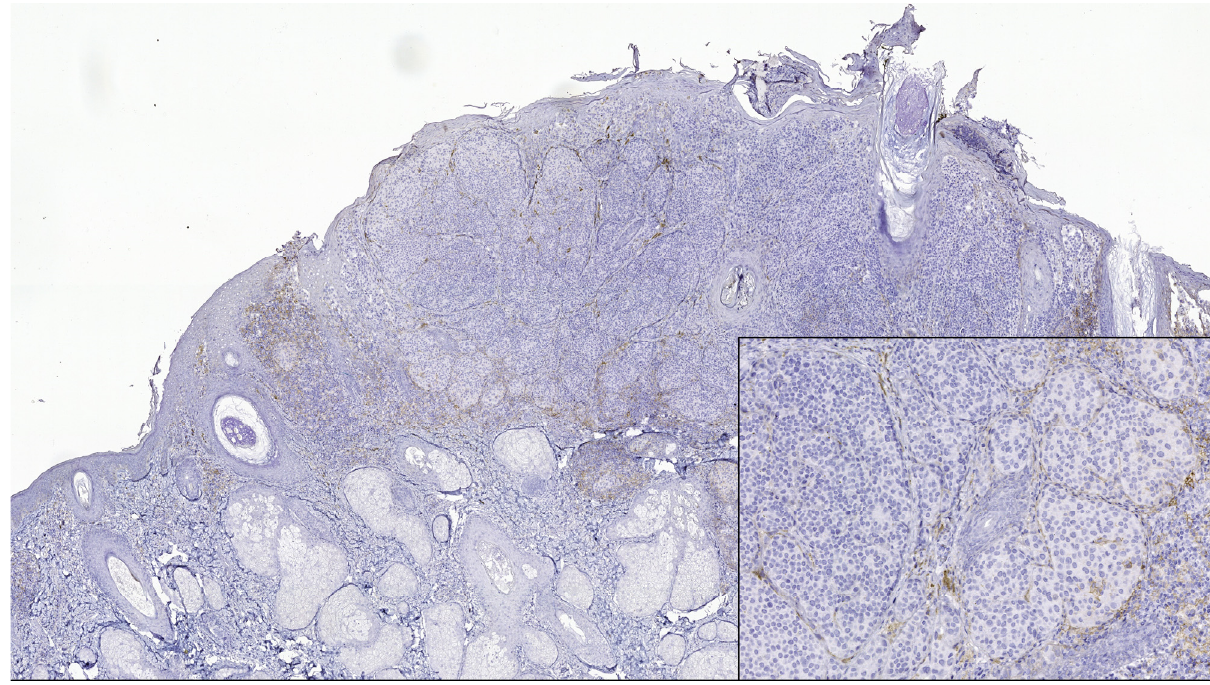
Figure 3. PD ‐ L1 negative expression in tumor cells and TILs of nodular melanoma (PD ‐ L1 Mono ‐ clonal Antibody, Clone CAL10). The brown staining is due to melanin pigment and melanophages. In the lower right side, detail ob.x100.